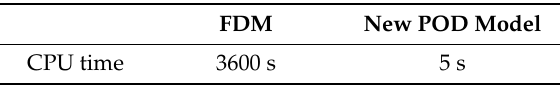
Table 5. Acceleration ability of the new POD